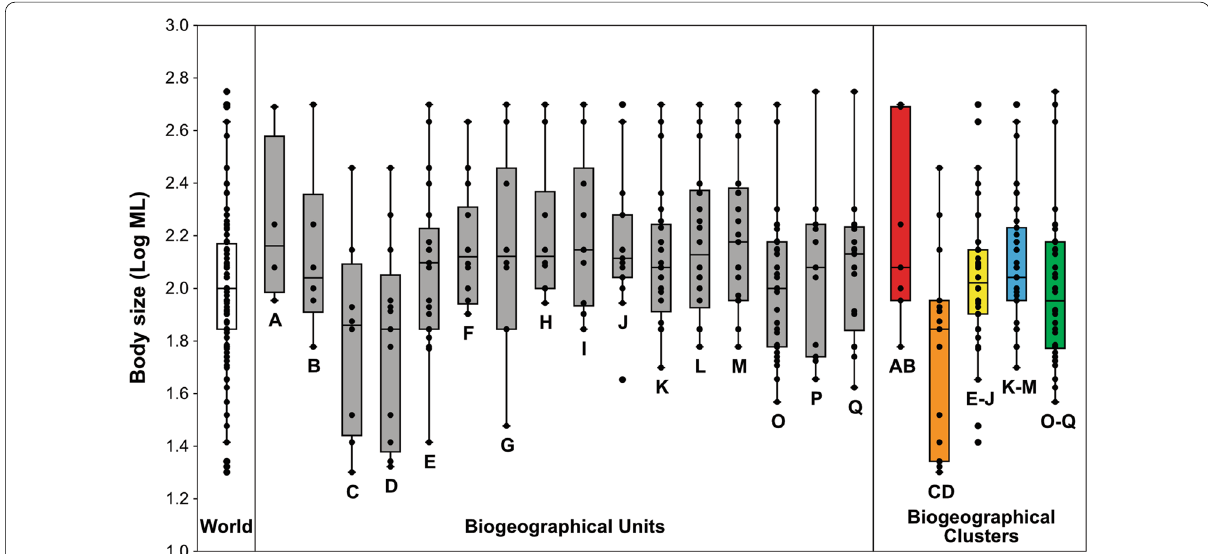
Fig. 5 Box and whisker plots for cuttlefish body size (Log ML): body size of species (points), mean, and standard error. Points not connected with the vertical bar are outliers. Left: for all living species of the world; middle: for each biogeographical unit; right: for the five biogeographical clusters (see text)